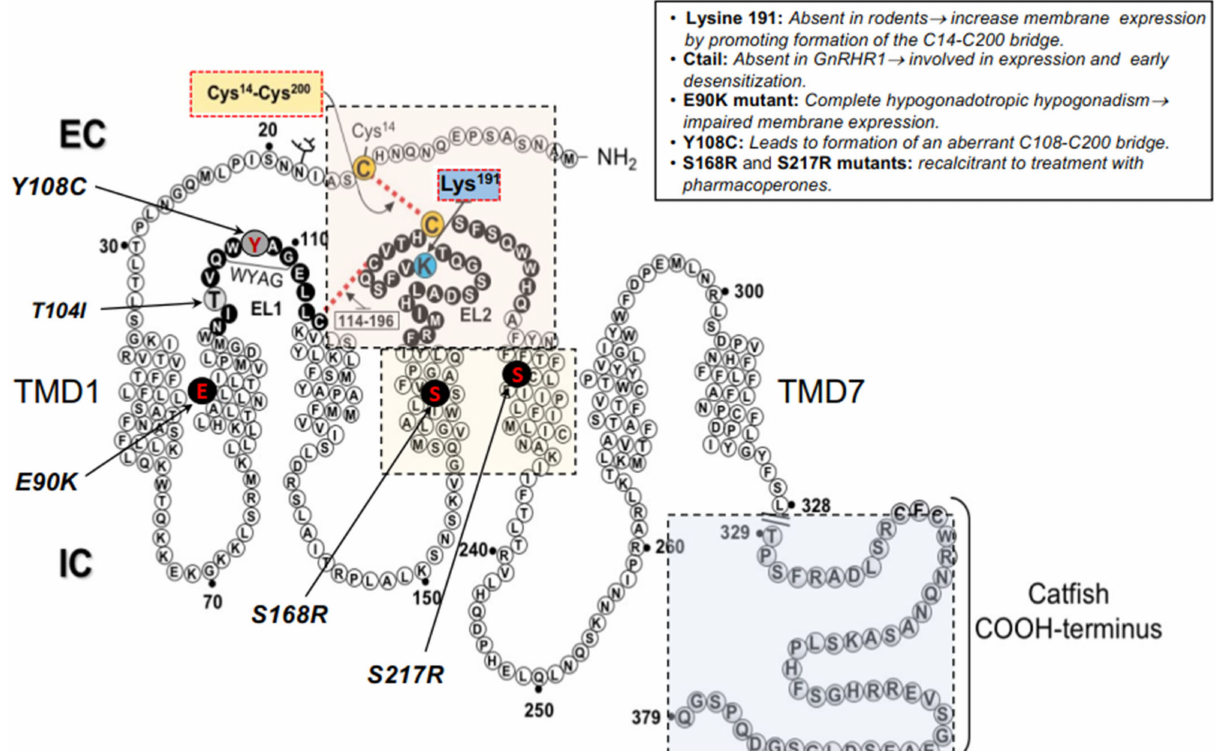
Figure 1. Schematic representation of the human GnRHR sequence, with circles representing amino acid residues. The red discontinuous lines within the light orange square, indicate the C14–C200 disulfide bridge, which helps to maintain the GnRHR in a conformation compatible with endoplasmic reticulum export and that is destabilized by the presence of lysine 191 (blue circle), as well as the C114–C196 bridge, which is a general structural requirement present in GPCRs belonging to the rhodopsin-like family. The light yellow square comprises the transmembrane domains (TMD) 4 and 5 which accommodates serine residues 168 and 217 that when replaced with arginine lead to severe, rescue-recalcitrant misfolding. The extracellular loop 1 (EL1) presents the conserved sequence Trp-Tyr-Ala-Gly (WYAG) [58]. In other rhodopsin-like GPCRs for peptides and biogenic amines, this sequence corresponds to the Trp-Xaa-Phe-Gly motif [(W/F)X ϕ G, in which ϕ is a hydrophobic residue], which has been shown to be important for agonist-mediated receptor activation [62]. The light-blue square encompasses the sequence of the Catfish Ctail, which has been experimentally employed to test the role of the Ctail in the hGnRHR. Also indicated are the mutations E90K, Y108C, and T104I, whose effects on hGnRHR trafficking have been explored in detail [63]. The upper right inset describes some features of the mutations shown in the schematization of the receptor as well as of K191 and the Ctail, which is absent in type 1 GnRHR (see text for